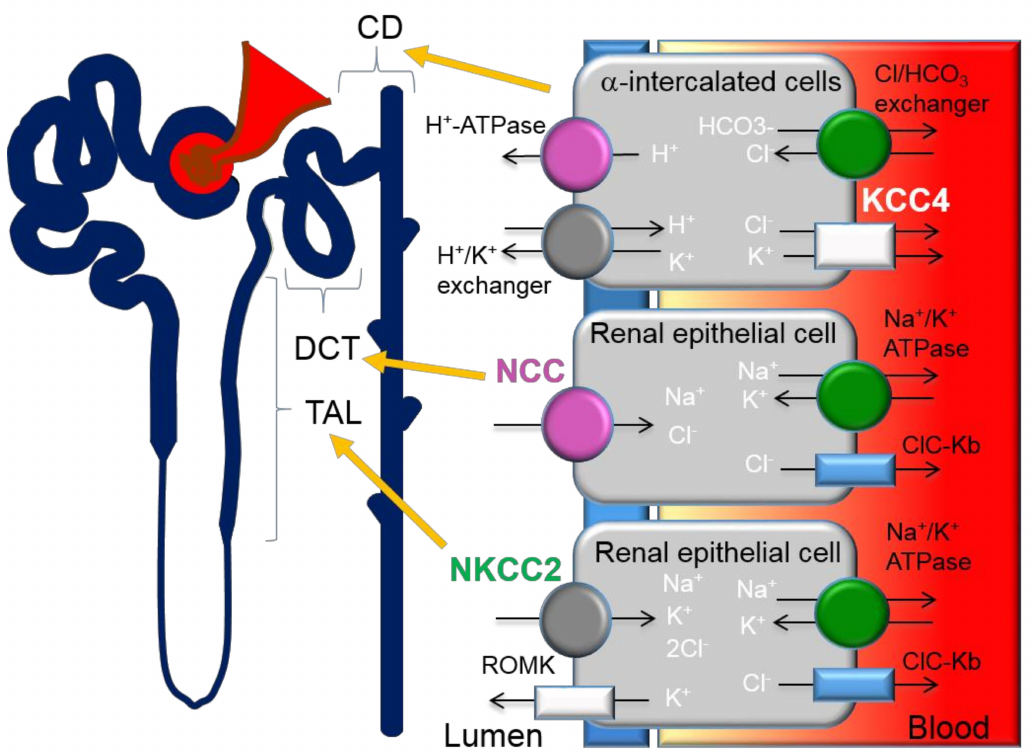
Figure 1. Expression of cation-chloride-cotransporters in the kidney. Alpha-intercalated cells in the collecting duct (CD) secretes acid via the apical H-ATPase and H + / K + exchanger and reabsorbs bicarbonate via the basolateral Cl / HCO 3 exchanger. E ffl ux of Cl − through the potassium chloride co-transporter-4 (KCC4) is important to maintain the electrochemical gradient to facilitate the acid secretion activities of the alpha-intercalated cells. Loss of KCC4 leads to renal tubular acidosis, which, if left untreated, could lead to cardiac arrhythmias. Sodium-chloride-cotransporters (NCCs) are exclusively expressed in the distal convoluted tubule (DCT). Gain-of-function mutations in regulatory genes that lead to the over activation of NCC cause Familial Hyperkalemic Hypertension (FHHt). Sodium potassium chloride cotransporters-2 (NKCC2) is expressed in the thick ascending limb (TAL). Loss-of-function mutations of NKCC2 results in the salt-wasting phenotype of type 1 Bartter